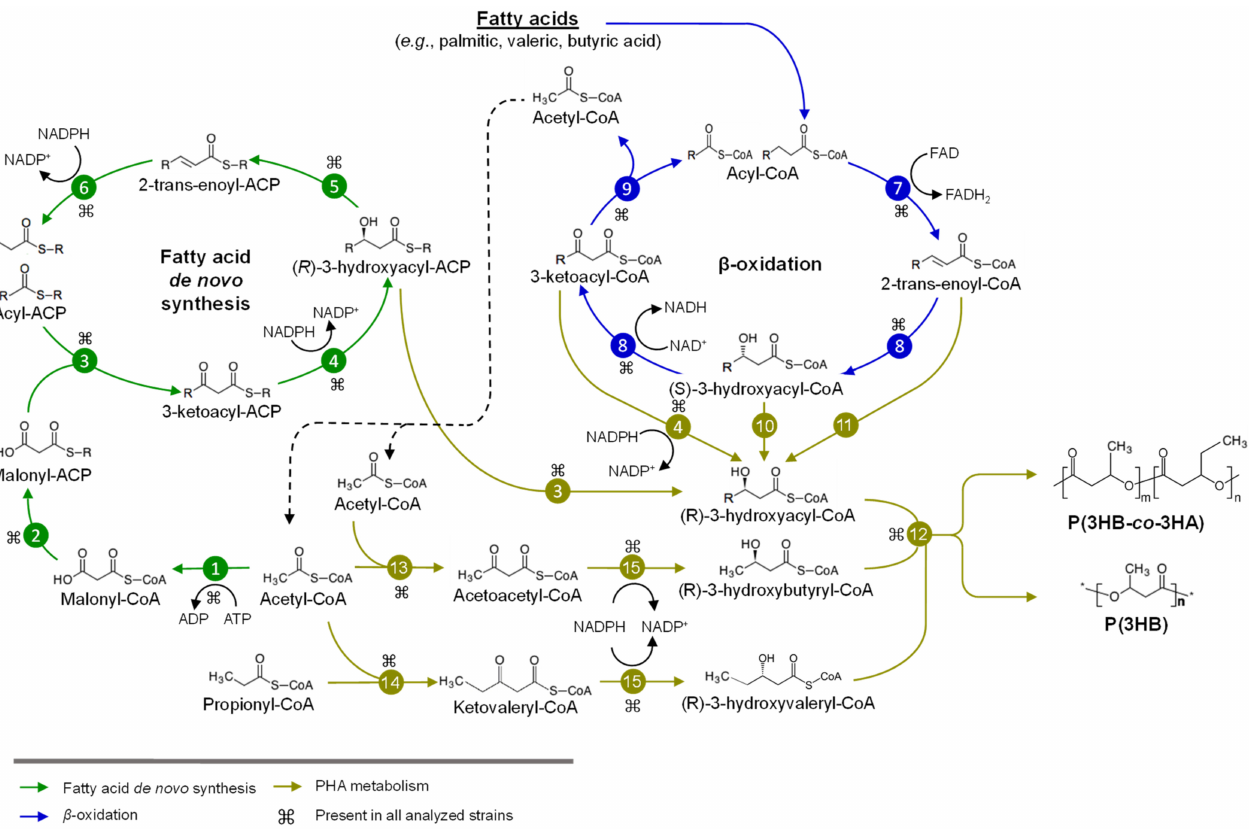
Figure 2. Proposed metabolic pathways from sugars and glycerol into the synthesis of polyhydroxybutyrate of Burkholderia Figure 3. Proposed metabolism of fatty acids associated to the synthesis of PHAs in Burkholderia sensu lato genera. Each reac- sensu lato genera. Each reaction is represented with an arrow with the respective enzyme depicted with a number. Com- tion is represented with an arrow, with the respective enzyme or enzymes that catalyze the reaction depicted with a number. pounds with their name underlined are carbon and energy sources for these bacteria. Enzymes present in all analyzed genomes are marked with “ ⌘ ”.1, β -fructofuranidase (FFase), α -glucosidase (MalL); 2, mannitol dehydrogenase (MDH); Enzymes present in all genomes are marked with “ 3, glucokinase (GLK); 4, glucose phosphoenolpyruvate transferase system (PTS) family transporter (glu-EII); 5, fructoki-